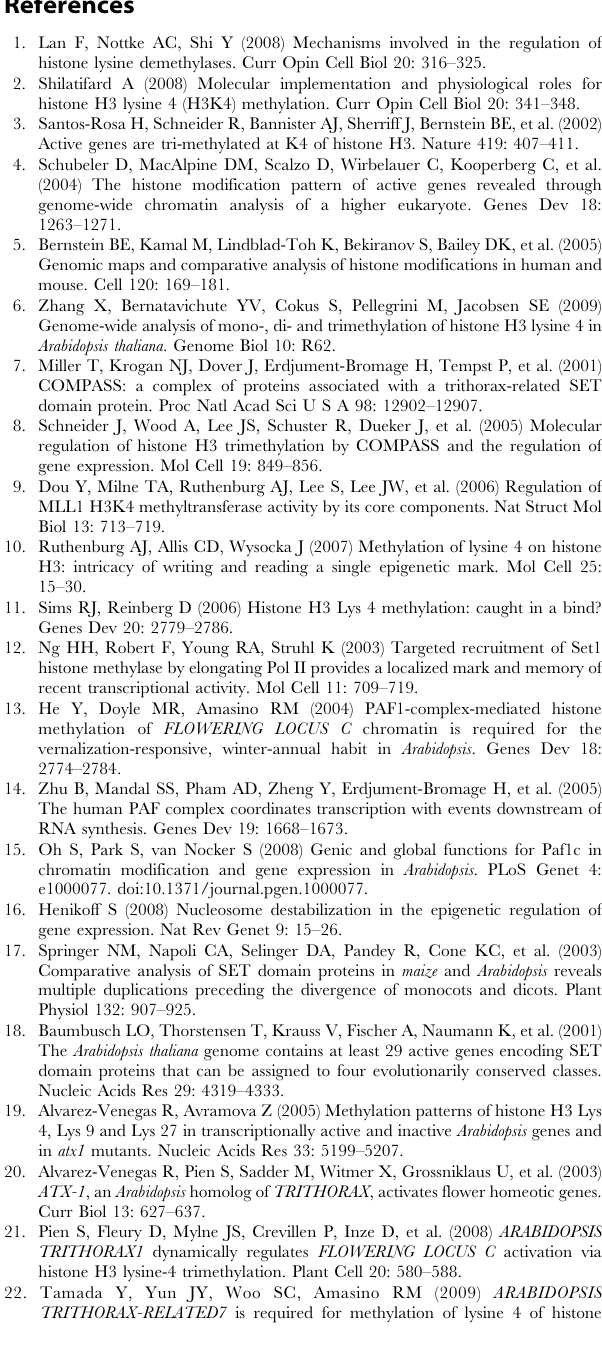
Table S1 List of WDR5 and RbBP5 Homologs from Repre- sentative Animal and Plant